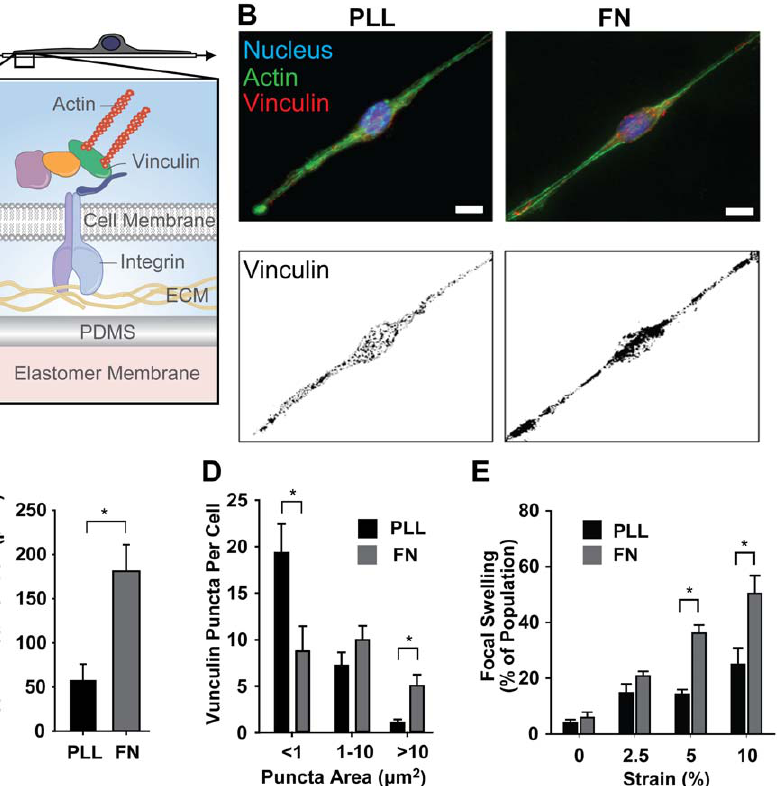
Figure 2. Substrate coating influences neuronal FAC formation and injury progression. ( A ) Neurons are mechanically coupled to the substrate via FACs that couple the intracellular cytoskeleton to the ECM. ( B ) Immunofluorescent imaging of vinculin puncta indicated the presence of FACs. Scale bars correspond to 8 and 10 m m, for PLL and FN respectively. Quantification of ( C ) total vinculin puntca area ( n =8) ( D ) indicated that a FN coated substrate induced FAC formation over a larger area and with greater average cluster size compared to a PLL coated substrate ( n =5). ( E ) The percentage of neurons that exhibited widespread focal swelling following stretch injury was greater on a FN coated substrate compared to a PLL coated substrate at 10 minutes ( n $ 4 for PLL and n $ 8 for FN). All bars SEM for all panels, * p , 0.05.